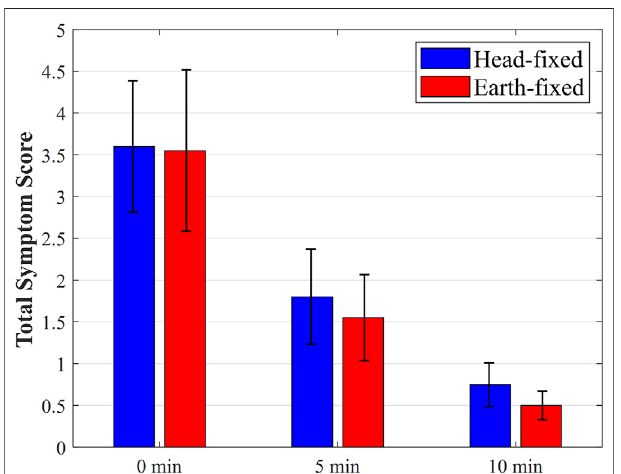
FIGURE 7 | Total symptom score.